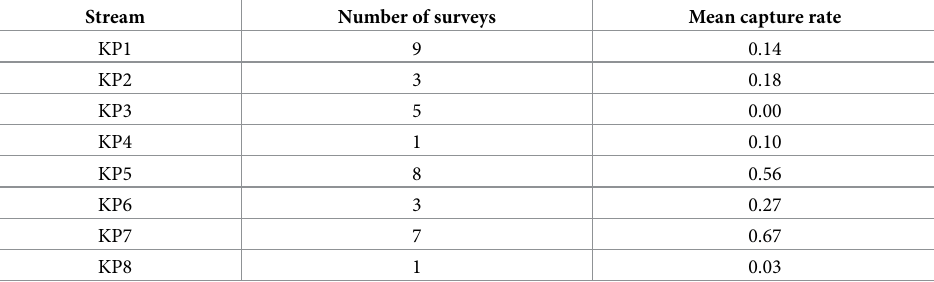
Table 2. Summary of trapping surveys throughout the eDNA sampling period at streams with known populations (KP). There were positive sightings of Platysternon megacephalum using active searching at all streams.